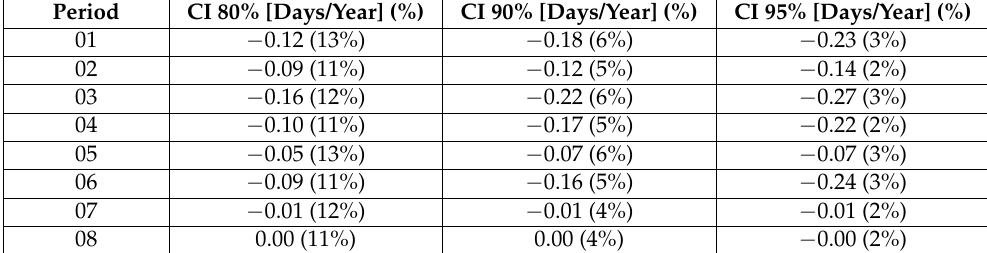
Table A1. Arithmetic mean of the slopes (scaled to days per year) of the pixel-based trend analysis for the three confidence intervals. Note that the pixels are a percentage of the total (not the total number